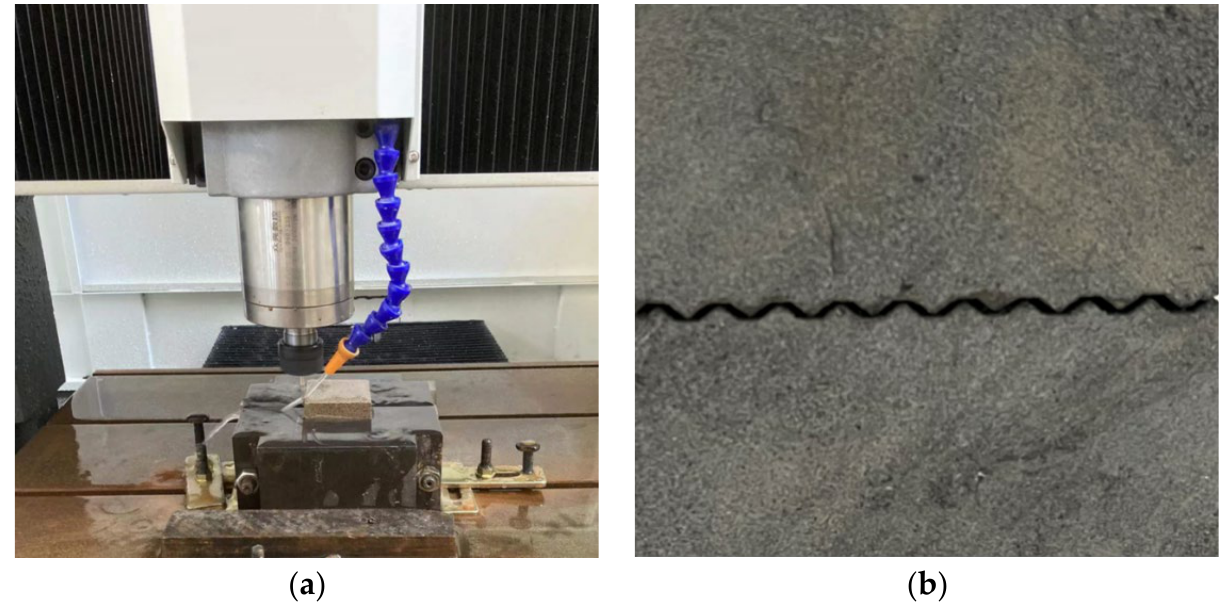
Figure 1. Machining process and carved rock sample of high-precision engraving machine. ( a ) Engraving process; ( b ) Carved rock sample.